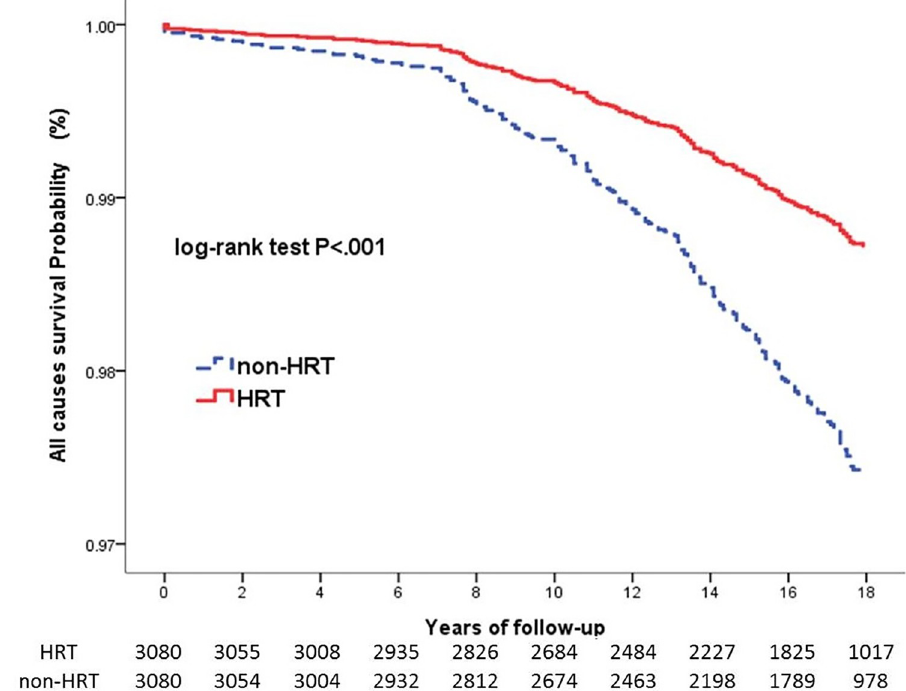
Fig 3. Survival curves of all-cause mortality in the HRT and non-HRT cohorts. HRT, hormone replacement therapy.